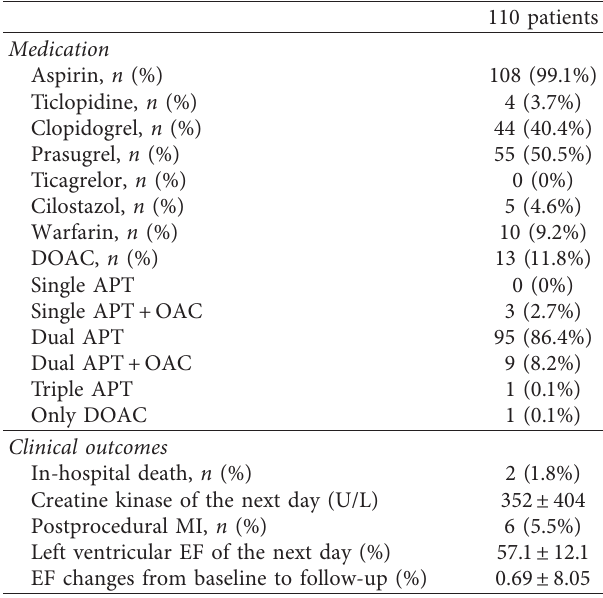
Table 3: Medication and outcomes after percutaneous coronary